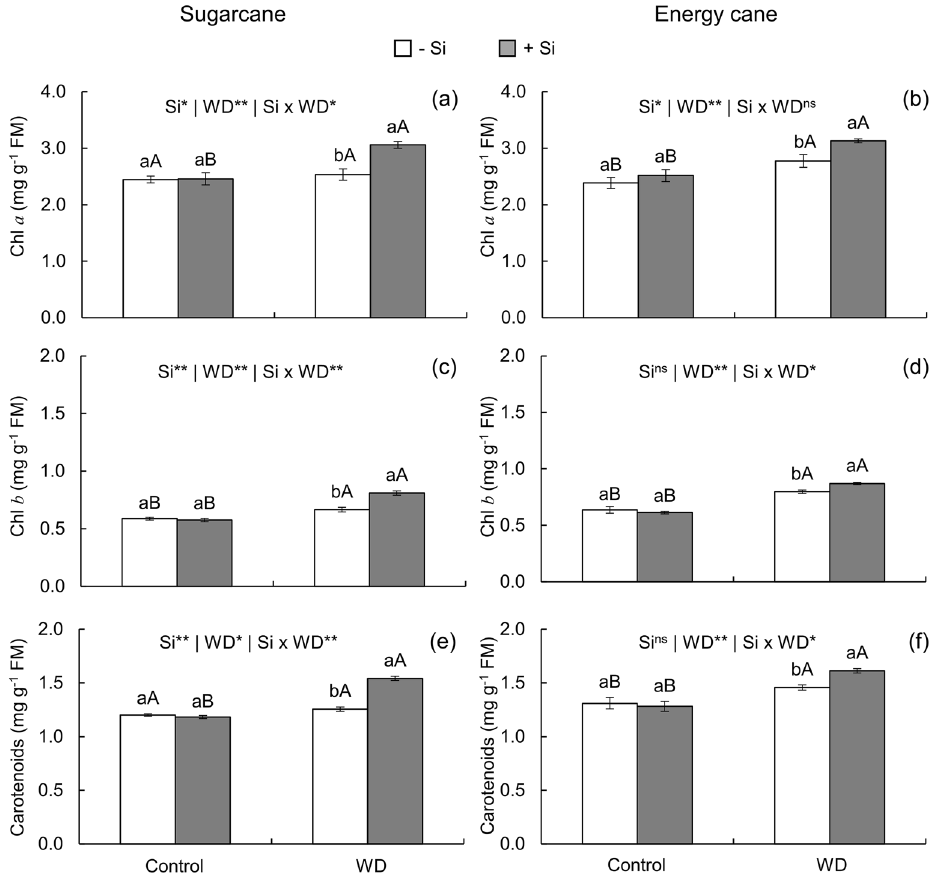
Figure 3. Chlorophyll a (Chl a ), chlorophyll b (Chl b ), and carotenoid content in sugarcane ( a , c , e ) and energy cane ( b , d , f ) in the absence of Si (-Si) and with Si applied via fertigation associated with foliar spraying (+ Si) under adequate water regime (control) and severe water deficit (WD) for a period of 7 to 160 days after transplanting. ** and * : significant at 1 and 5% probability, respectively; and ns : not significant by the F-test. Different lowercase letters indicate differences in relation to Si in the same water regime; different capital letters indicate differences in relation to the water regime in the same conditions of Si supply, both by the Tukey test. Bars represent the standard error of the mean; n = 5. FW = fresh